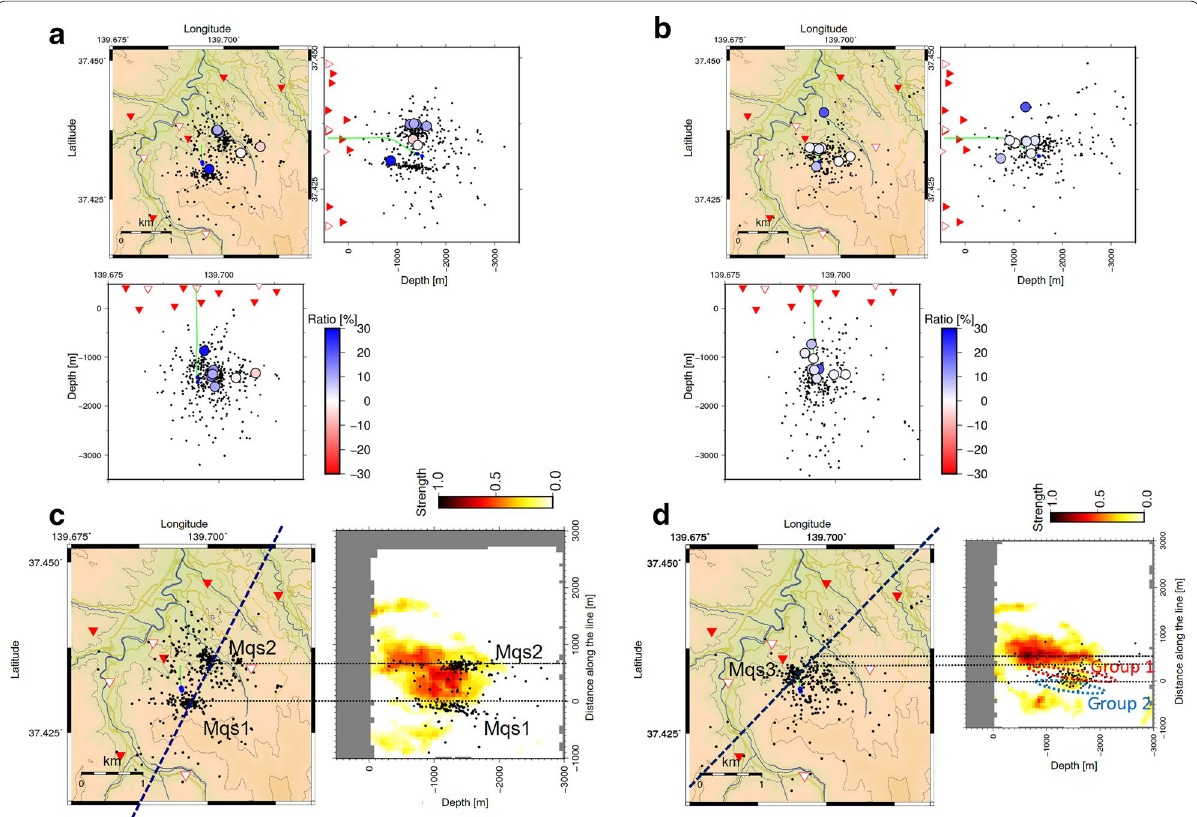
Fig. 4 Estimation of water flows around microseismic clusters. a , b Variation in elastic wave velocity in rock fractures in a Phase 2 and b Phase 3 compared to the velocity in Phase 1. Velocity variation is shown by the color of each circle. Each circle is at the hypocenter of the analyzed earth- quakes. c , d Cross sections of the fractures and distributions of microseismic events along the blue dashed line in the horizontal map. Results for c Mqs1 and 2 and d Mqs3. The color scales at the top of c and d indicate the probability that a fracture